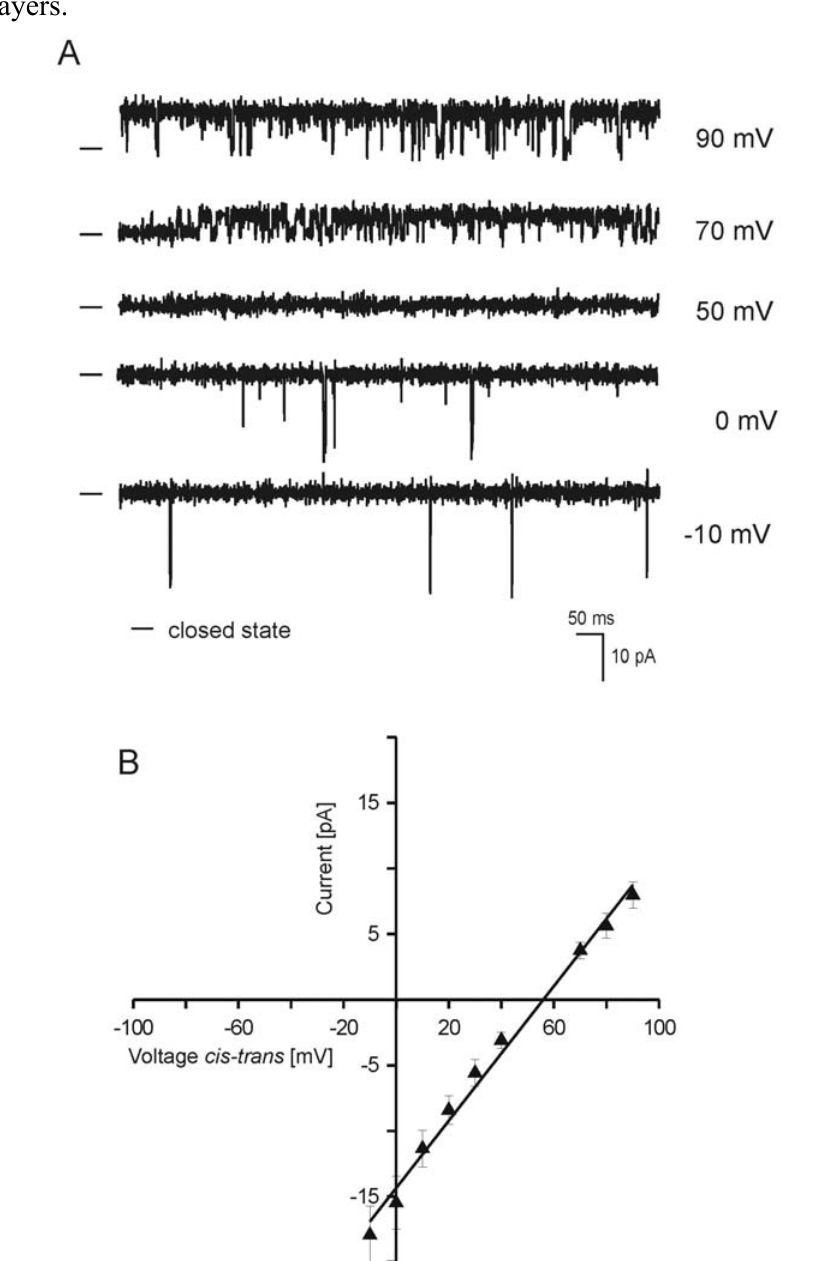
channel in planar Ca